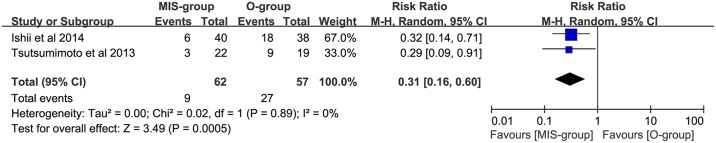
The comparing of radiograph ASDeg incident rate between MIS and open groups.